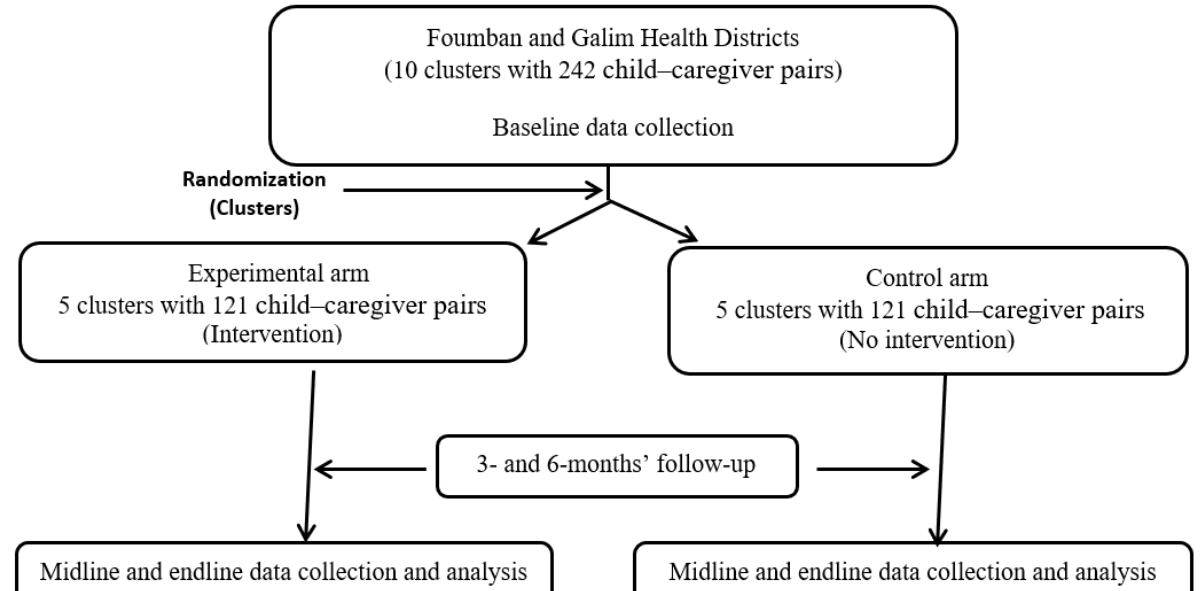
Figure 1. Flow chart showing cluster randomization and follow-up for the nutrition, water, sanitation, and hygiene (Nu-Wash)